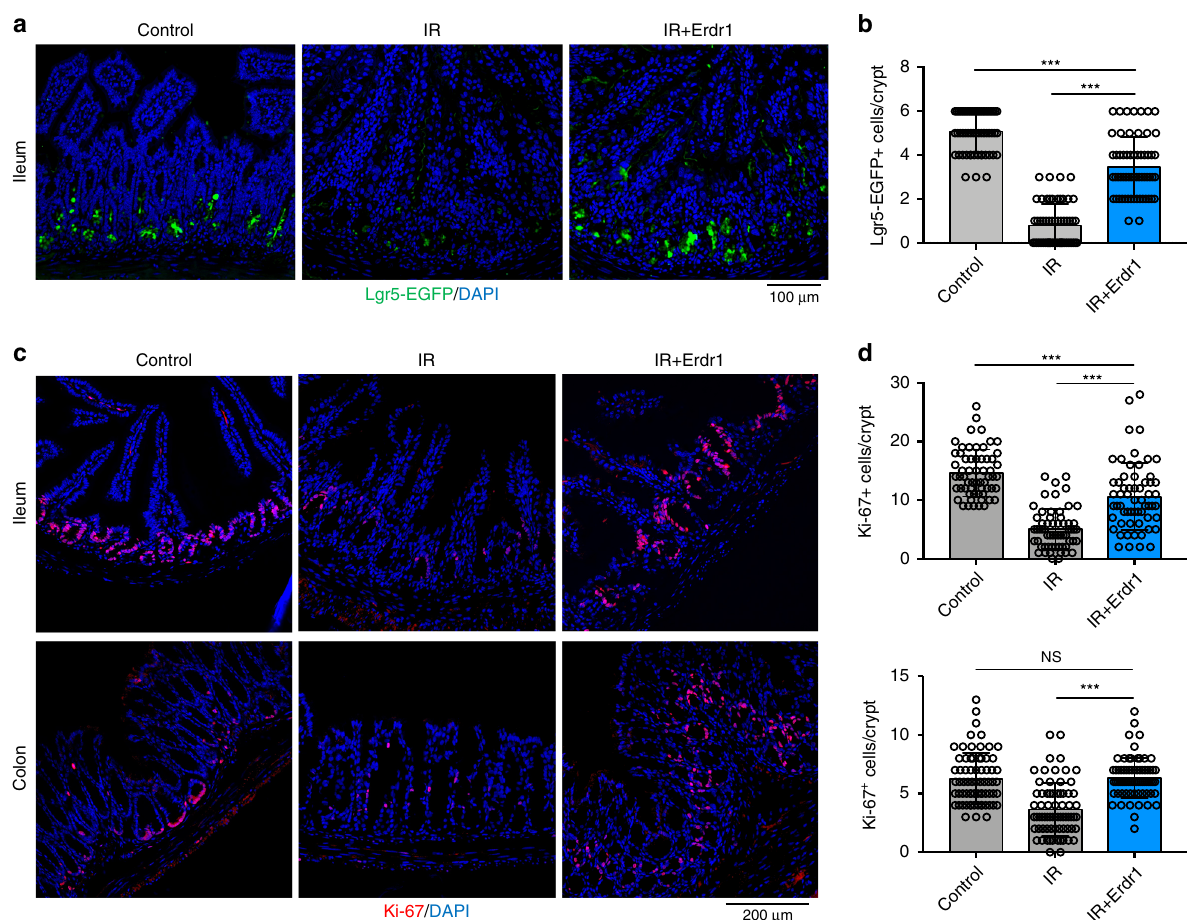
Fig. 7 Erdr1 promotes the regeneration of Lgr5 + ISCs following radiation-induced injury. a Representative images of EGFP staining in ileum sections from Lgr5-EGFP reporter mice housed in SPF conditions. Mice were injected ±Erdr1 daily following 10 Gy irradiation. b Quanti fi cation of Lgr5-EGFP + cells per crypt. n = 60; representative of three experiments. c Representative images of Ki-67 staining in ileum and colon sections (pink, Ki-67; blue, DAPI). d Quanti fi cation of Ki-67 positive cells per crypt from the ileum (top) and colon (bottom). n = 60; representative of three experiments. All data are presented as mean ± SD; * P < 0.05, ** P < 0.01, *** P < 0.001 by one-way ANOVA with Tukey ’ s multiple comparison